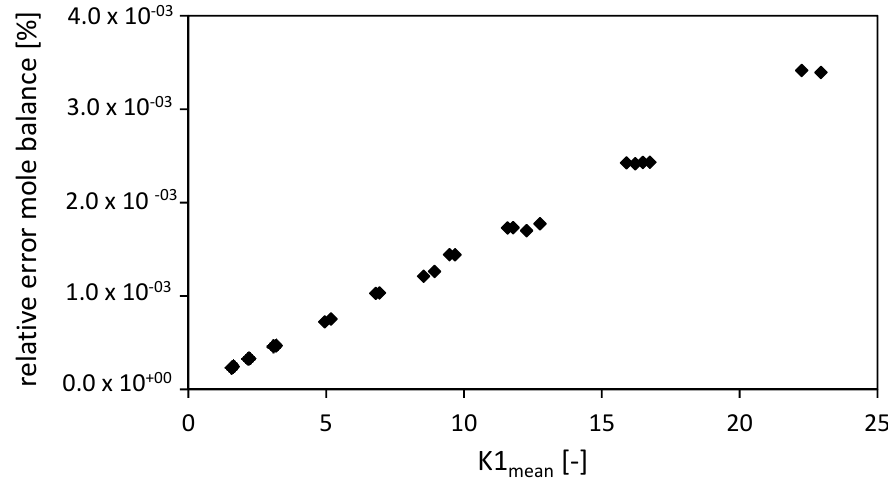
Figure 9. Relative error of the mole balance of the FVM with the settings used in Selmer et al. 2019 [3] depending on the dimensionless number K 1 mean . Drying conditions: P = 9–17 MPa, T = 315–326 K, R = 3.175 mm, gel porosity = 0.93, gel tortuosity = 3.48, x (cid:2870),(cid:2917)(cid:2929)(cid:2930)(cid:2911)(cid:2928)(cid:2930) = 1, x (cid:2870),(cid:2917)(cid:2915)(cid:2924)(cid:2914) = f(T), bed porosity = 0.4, packed bed = 1.514 × 10 − 4 m 3 , diameter packed bed = 2.1 × 10 − 2 m, N = 26, ∆ t = 0.1 s, S =